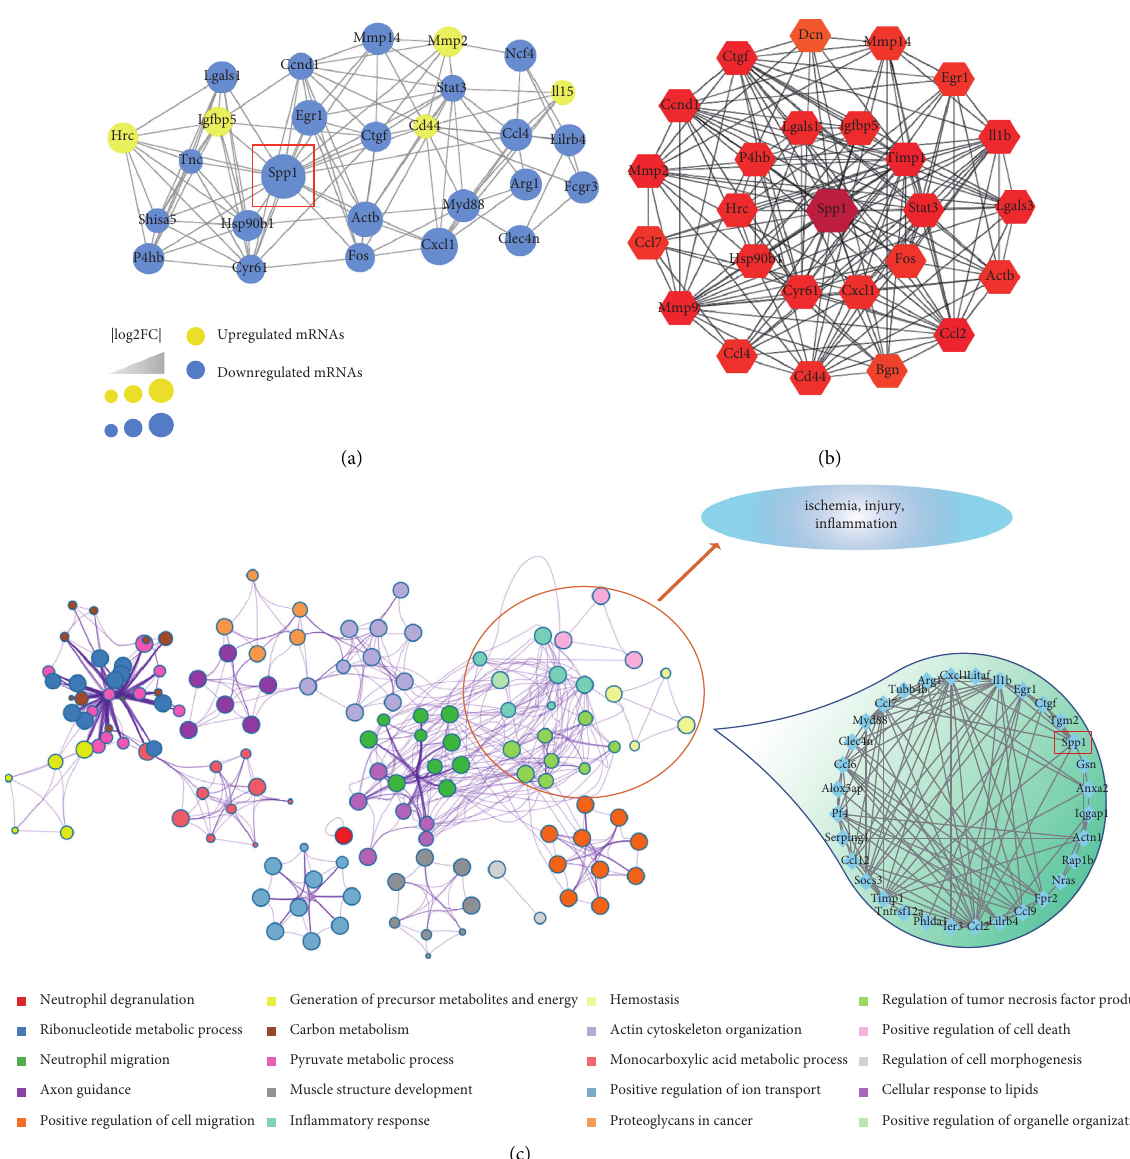
Figure 3: Spp1 was identified as the hub gene associated with ischemia, cell injury, and inflammation. (a) The PPI network indicated the interaction of 27 hub genes. (b) Hub gene network was obtained through Cytoscape, and Spp1 obtained a high score. (c) The functional clustering indicated Spp1 as a hub gene involved in ischemia, cell injury, and inflammation in the connection tissue using the Metascape